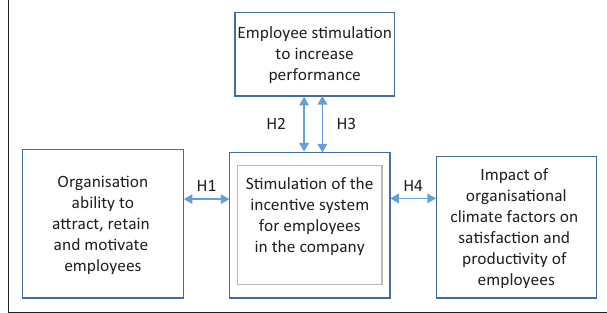
FIGURE 2: The model of an incentive system .